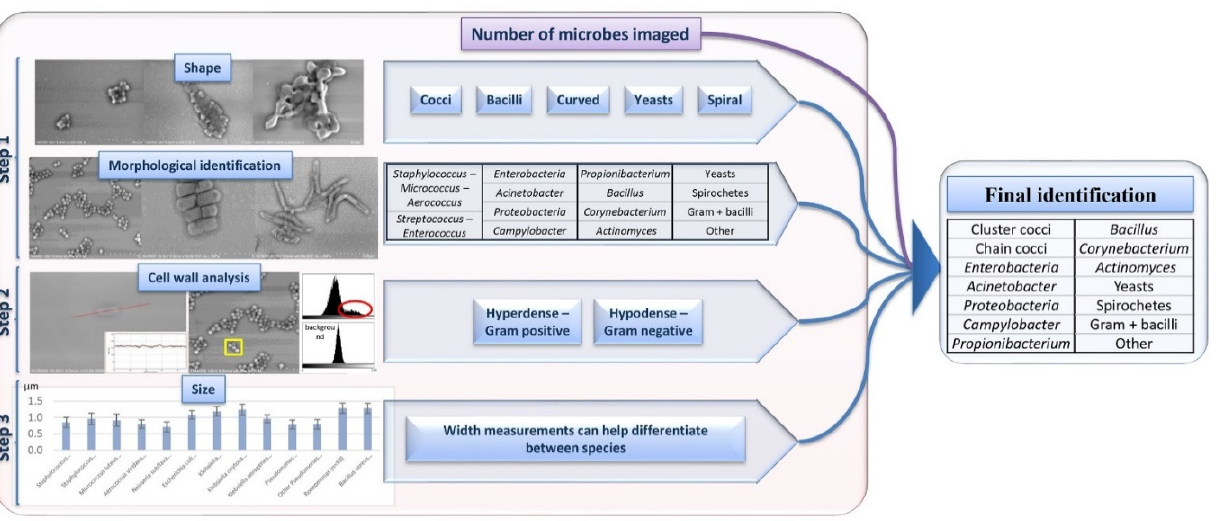
Figure 3. Merging steps 1, 2, and 3 allowed us to build a robust analysis for microbe identification .